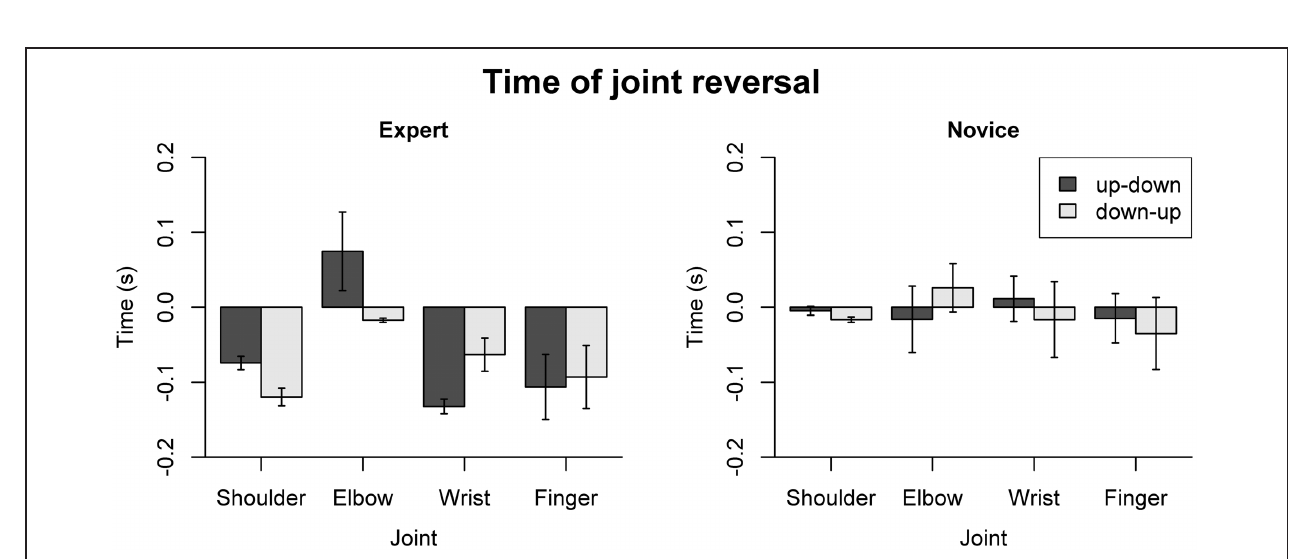
FIGURE 7 | Dependent variables derived from acceleration patterns of the bow and right arm, normalized relative to the right shoulder. (A,B) Time of peak acceleration. (C,D) Acceleration at bow reversal. Error bars indicate SE across participants.